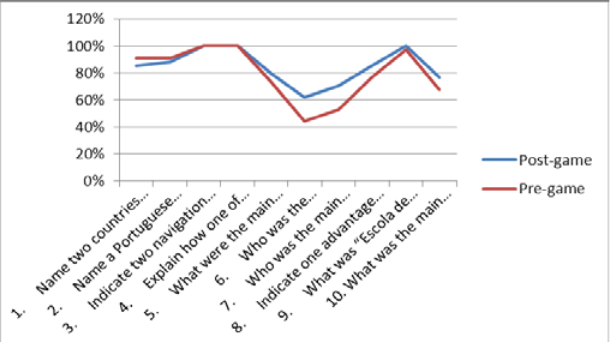
Figure 6. Student motivation, competence perception and game interest